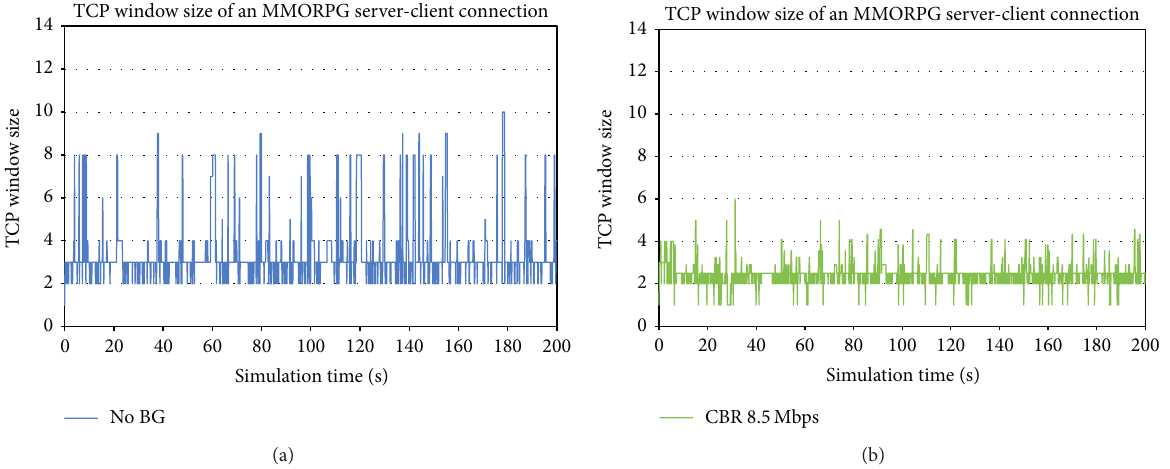
and server A are at a disadvantage. The RTT of the bottleneck (RTT0) is always 40